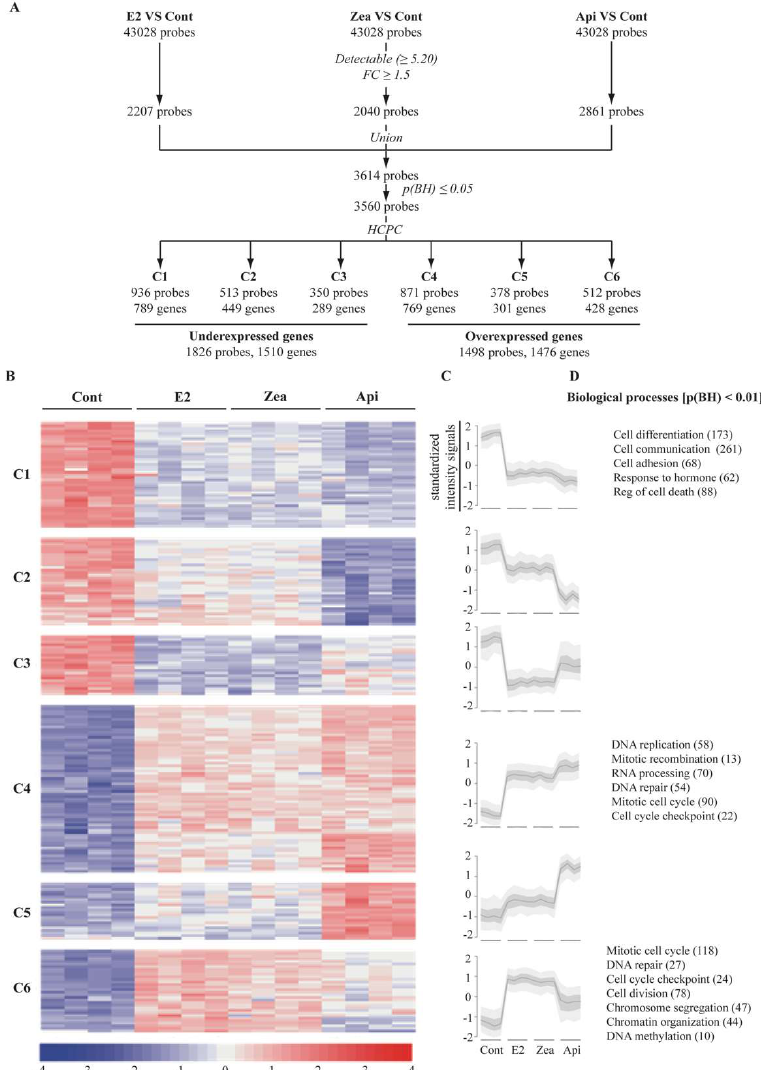
Figure 5. Transcriptomic analysis, selection and clustering of differentially expressed genes. MCF-7 cells were treated with solvent (Cont), 10 −9 M E2, 10 −8 M zearalenone (Zea) or 10 −5 M apigenin (Api) for 24 h. Total RNA was extracted, reverse transcribed, labeled and spotted onto a DNA chip. ( A ) To select differentially expressed genes, each treatment was compared to the control, and all probes with both an intensity signal above the overall median and a fold change ≥ 1.5 were chosen. Then, the probes were combined and submitted to a LIMMA test; only probes with a p -value < 0.05 were selected, resulting in a total of 1510 underexpressed genes and 1498 overexpressed genes. ( B ) These genes were clustered into 6 clusters depending on their expression patterns. ( C ) Intensity signals were standardized, and the expression profile of each cluster is presented. Major biological processes significantly associated ( p -value < 0.01) with the different clusters are noted ( D ). The number of differentially expressed genes corresponding to each gene ontology (GO) term are indicated in